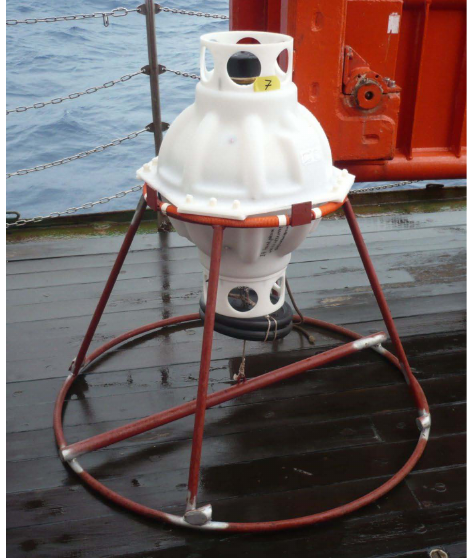
Fig. 12. PACT bottom unit and steel stand. The black cylinder at the top is the modem; the burn-wire release of the BU is located in the lower cage. For deployment, additional weights are attached between the release and the steel